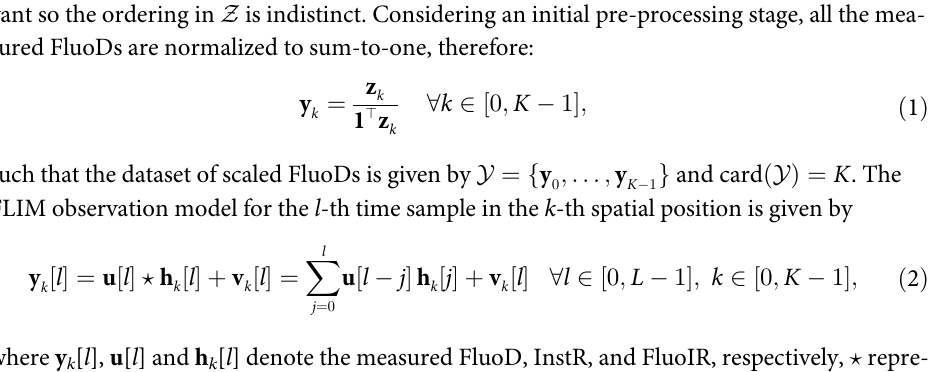
½ l �g K (cid:0) 1 result from the convolution k k ¼ 0